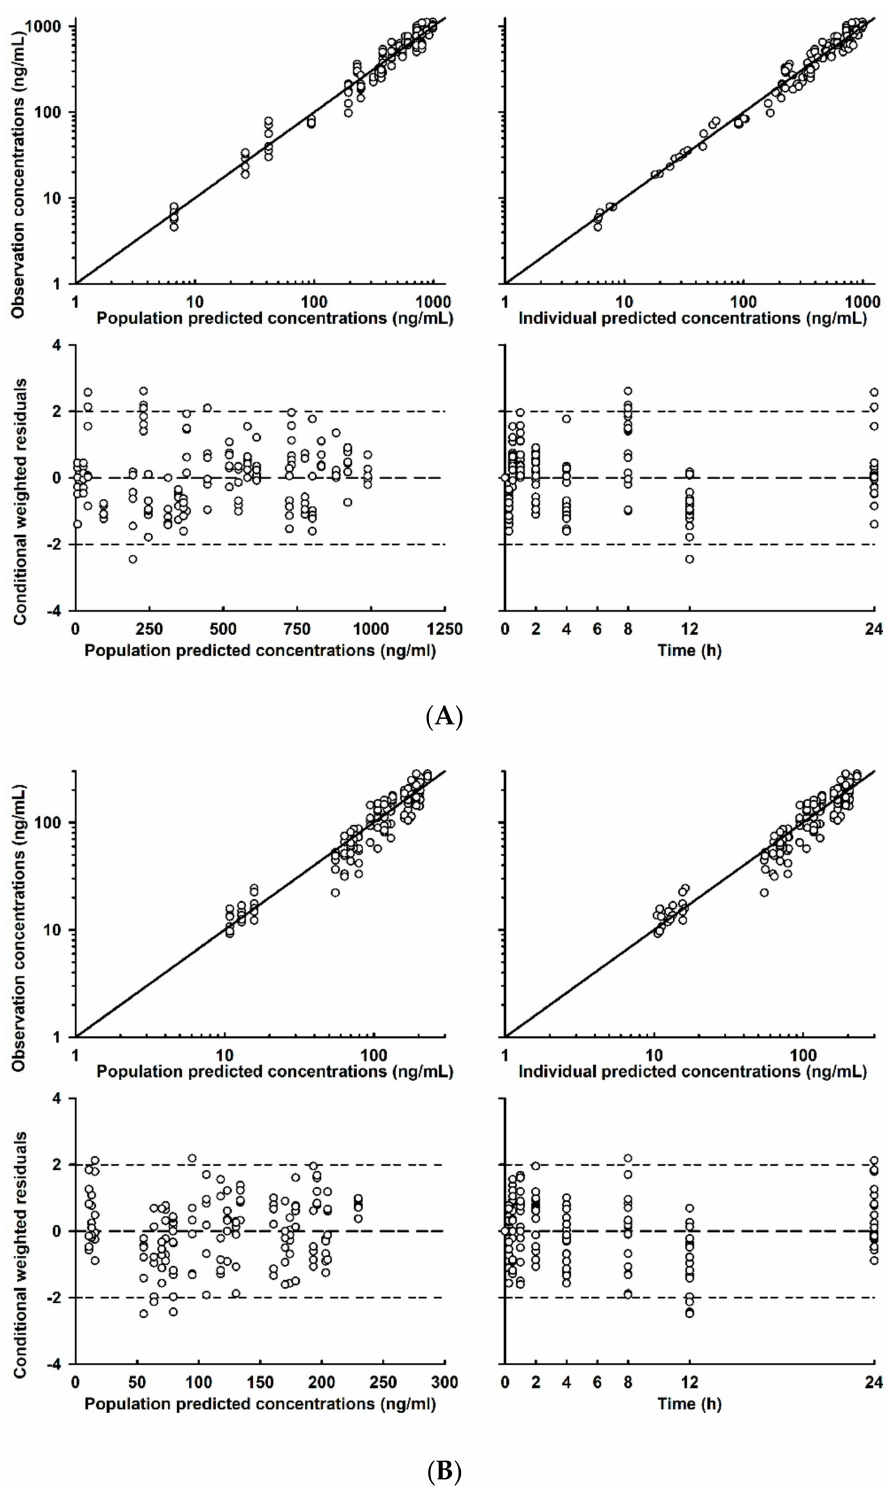
Figure 3. Goodness of fit plots for the final model for predictions of the PK profiles of ( A ) DLX and ( B ) 4-HD in